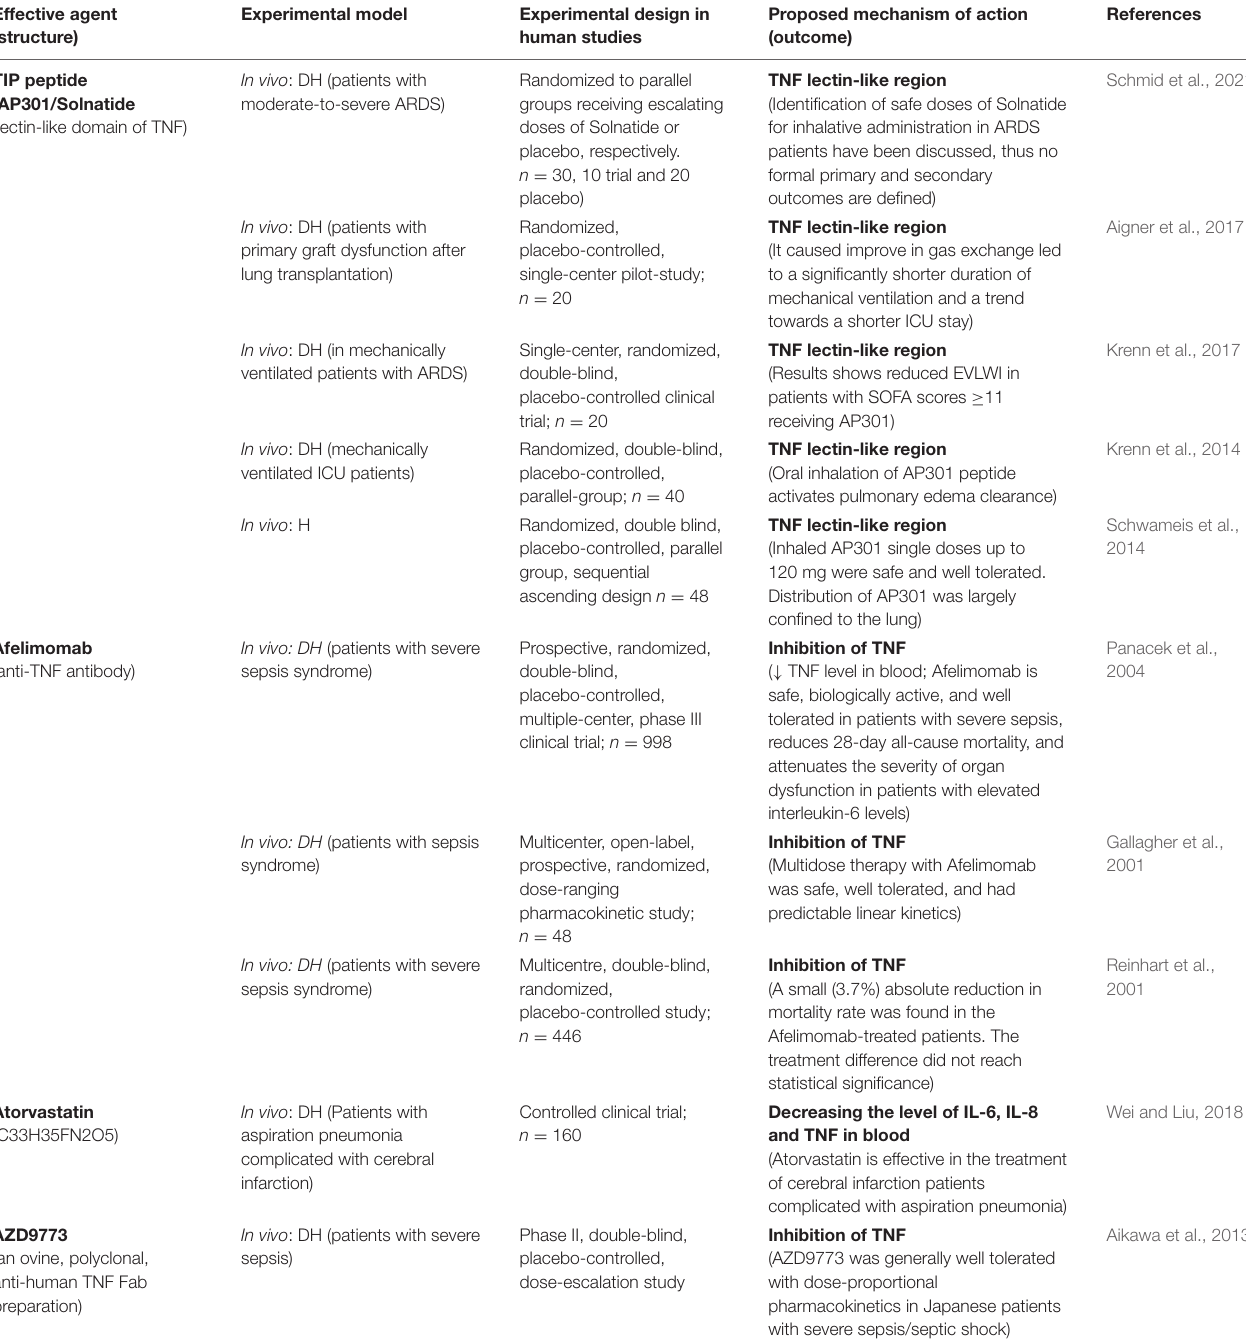
TABLE 1B | Impact of TNF inhibitor/stimulators or lectin-like domain stimulators in experimental settings using human trials with diseased human beings (DH) or volunteer human beings